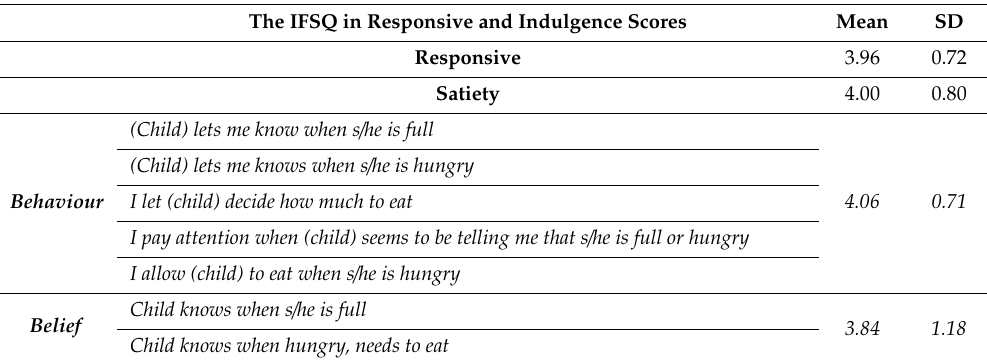
Table 2. IFSQ in responsive and indulgence scores ( n =